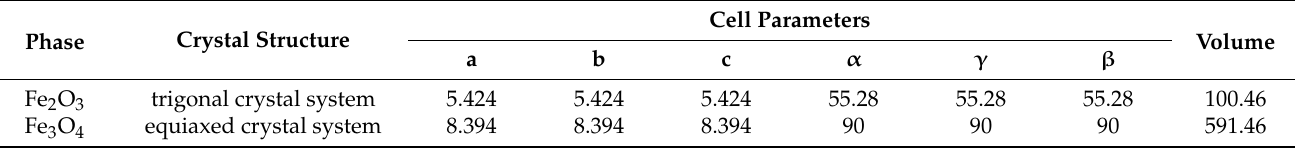
Table 9. Lattice parameter of Fe 2 O 3 and Fe 3 O